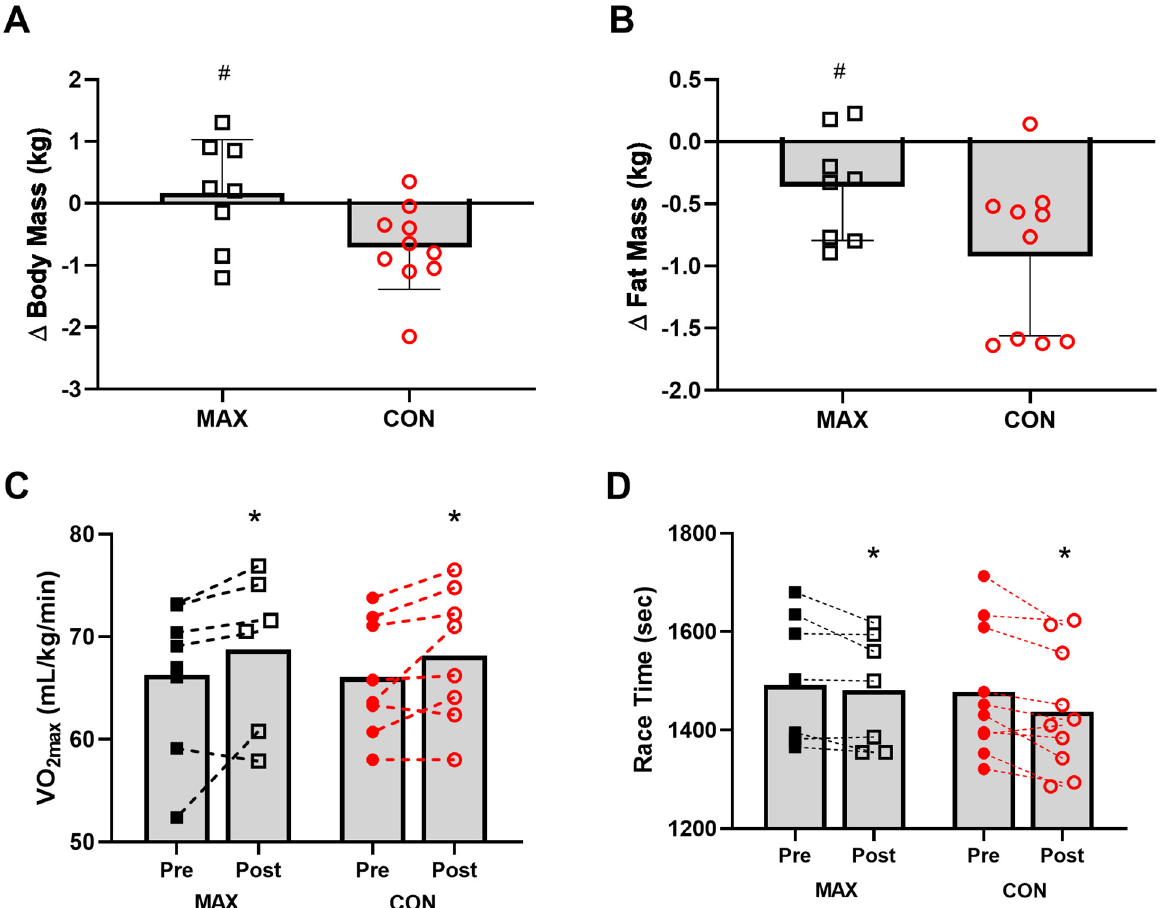
Figure 4. Changes in body mass (kg) ( A ), and fat mass (kg) ( B ) on morning of 35 km race in highly trained marathon runners before (Pre) and after (Post) a protocol to increase endogenous and exogenous CHO availability (MAX) compared with a control condition (CON) involving moderate CHO availability. Relative maximal oxygen uptake (mL · kg − 1 · min − 1 ) Pre and Post intervention ( C ) and running performance time (s) for the 7 km time trial ( D ) shown for both groups. Data are presented as mean ± SD. * = significant difference Pre- and Post-intervention; # = significant difference between CON and MAX. Closed squares and circles represent individual data for Pre, open squares and circles represent individual data for Post. ∆ = change in reported variable.